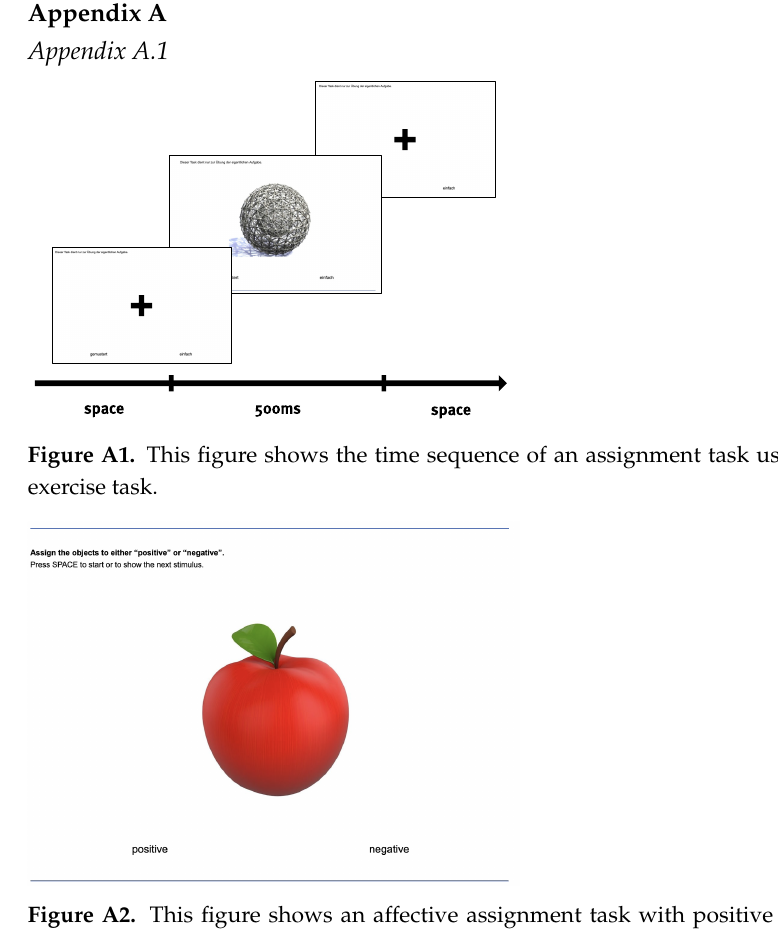
Figure A2. This figure shows an affective assignment task with positive and negative selection options using the visual stimulus “apple” as an example.